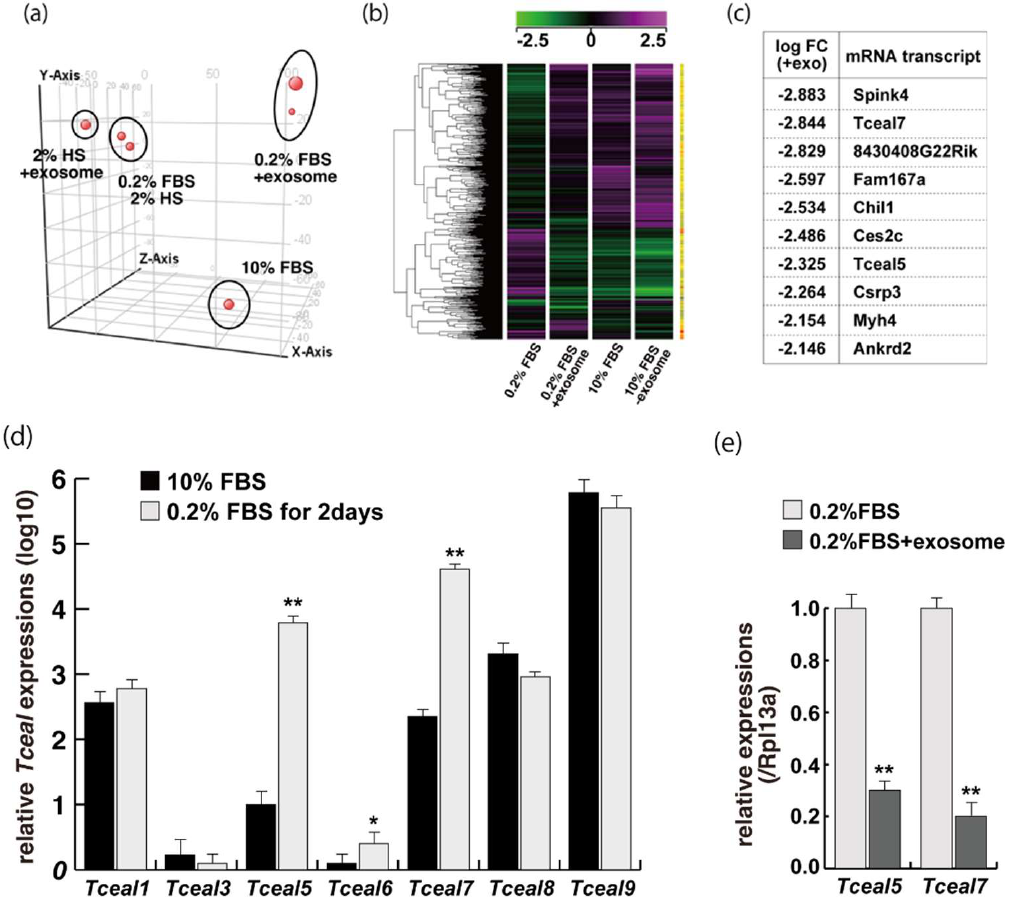
Figure 3. Identification of downregulated genes in differentiating myogenic cells cultured in the presence of added exosomes. ( a ) Principal component analysis, ( b ) heatmap of NGS data, illustrating differentially expressed messenger RNAs between 0.2% of FBS differentiating medium (0.2% FBS), 0.2% of FBS supplemented with exosomes (0.2% FBS + exosome), 10% of FBS (10% FBS), and 10% of exosome-depleted FBS (10% FBS − exosome); ( c ) TOP10 downregulated genes in differentiating C2C12 cells cultured in the presence of additional exosomes; ( d ) transcriptional changes in the Tceal family of genes in growing (10% FBS) and differentiating (0.2% FBS) C2C12 cells; ( e ) relative RT-qPCR of Tceal5 and Tceal7 transcripts in differentiating muscle cells with or without additional exosomes. Data represent means ± SEM ( n = 3). The statistical analysis was performed by Mann–Whitney U test. * p < 0.05, ** p < 0.01.